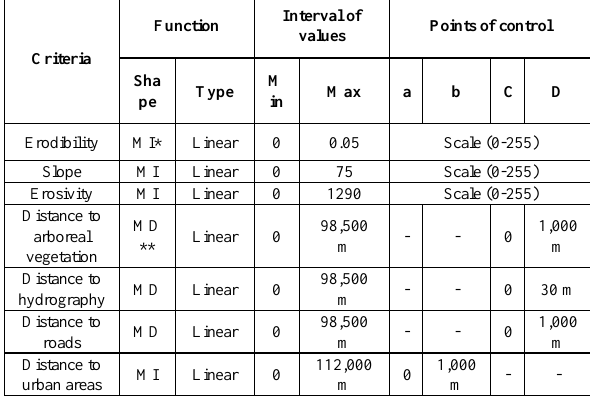
Table 2. Data and methodology used for designing the